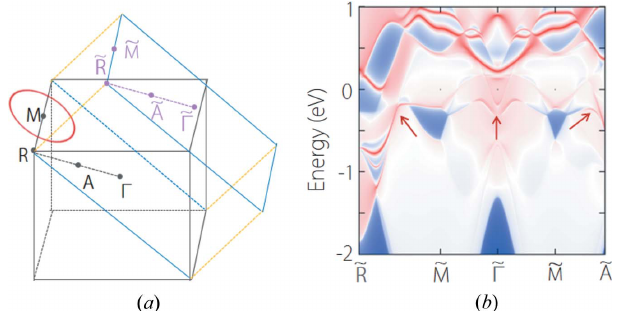
Figure 12 ( a ) Brillouin zone of the bulk and the (101) surface for YCd. The point A is the midpoint between (cid:2) and R . The red circle denote the nodal line. ( b ) Projected spectrum on (101) surface. The red arrows point to the drumhead surface states.